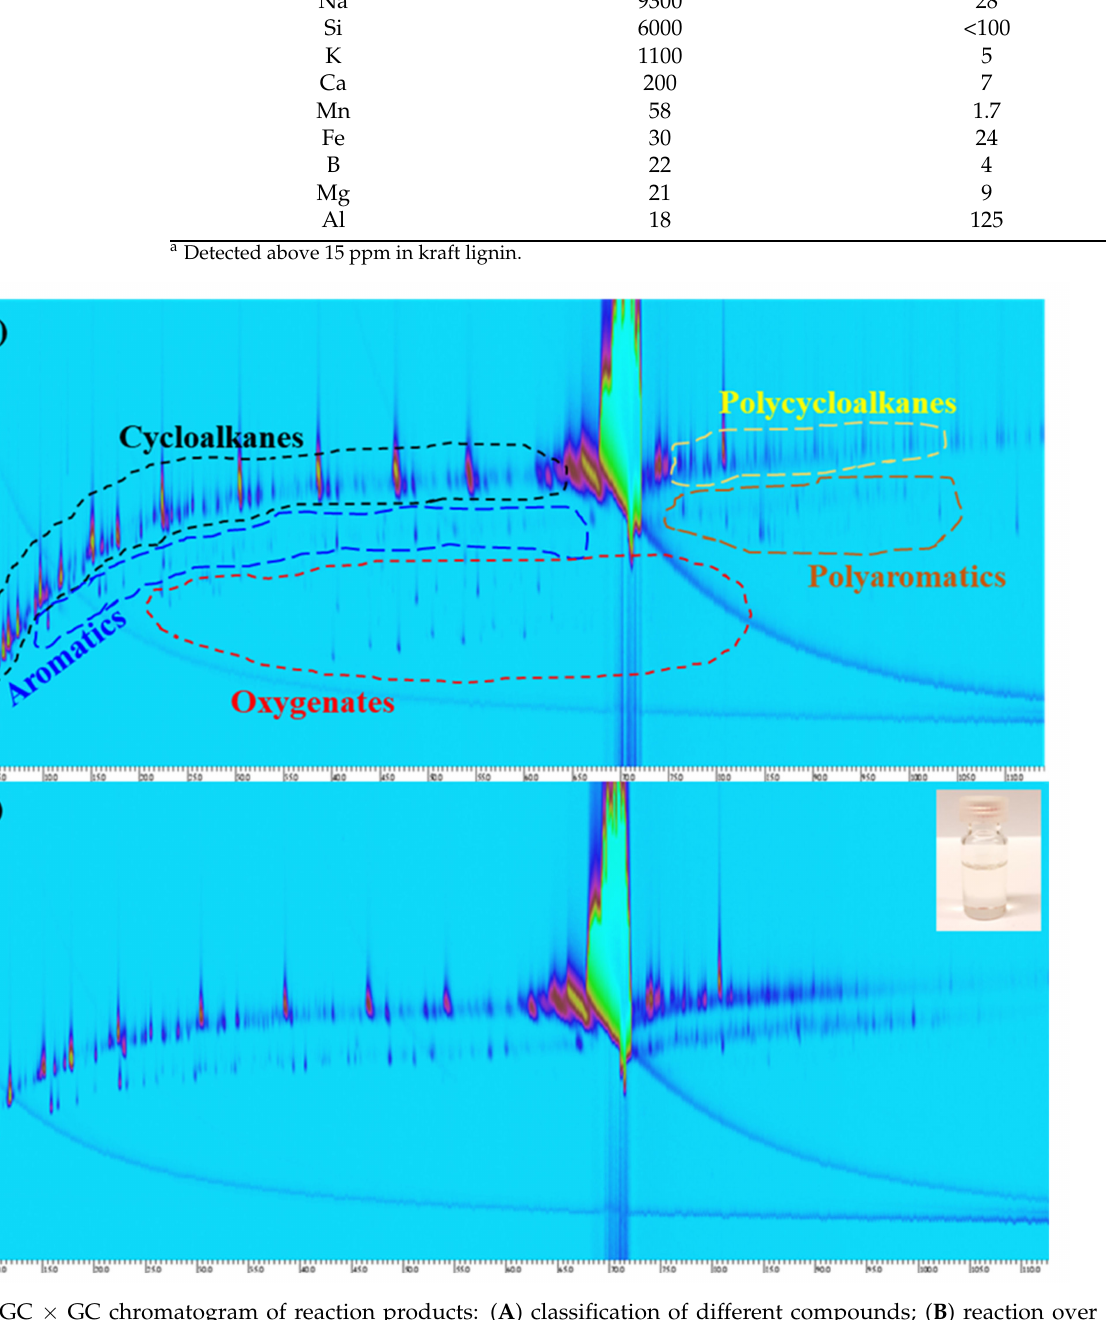
Figure 1. GC × GC chromatogram of reaction products: ( A ) classification of different compounds; ( B ) reaction over NiMoS/Al 2 O 3 catalyst; inset shows an image of the liquid